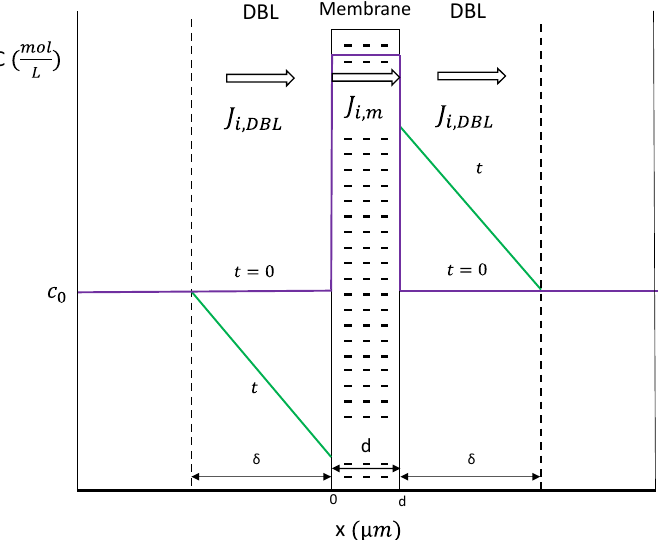
Figure 1. Scheme of the system simulated formed by a cation-exchange membrane surrounded by two diffusion boundary layers and portions of bulk solution. Concentration profiles are represented in the y-axis versus the spatial coordinate x for the initial and steady-state conditions.